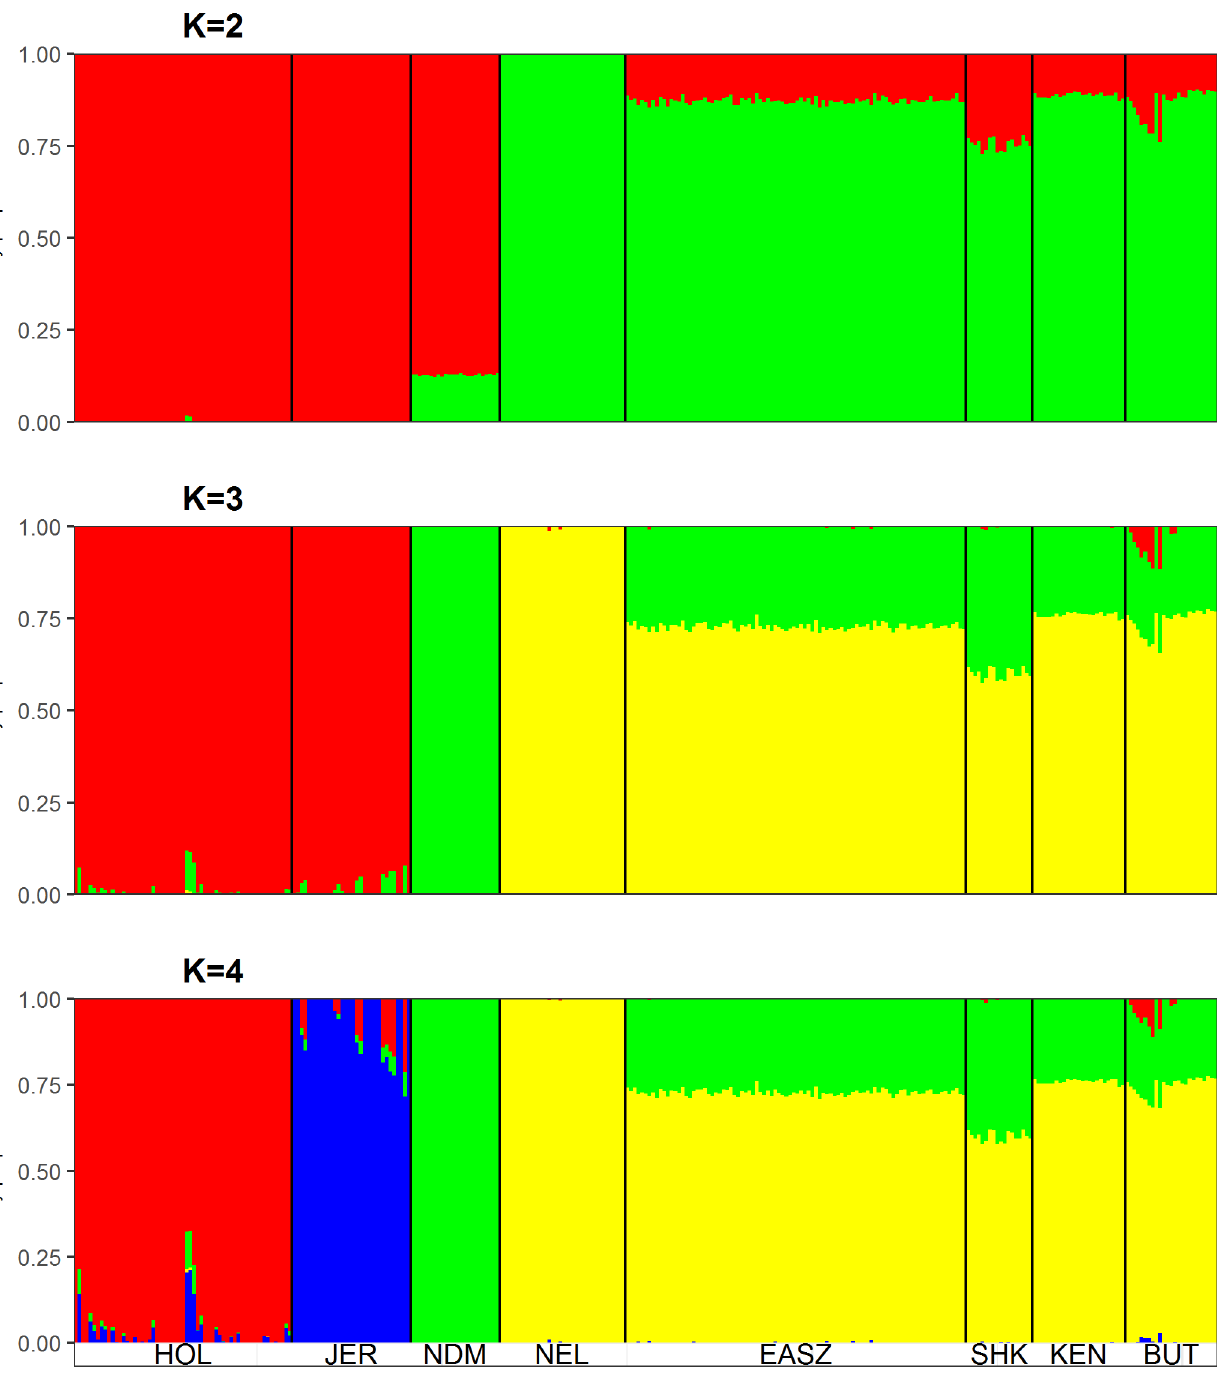
respectively, are significantly enriched (enrichment score > 1.3), relative to the bovine genome “Table 1”.